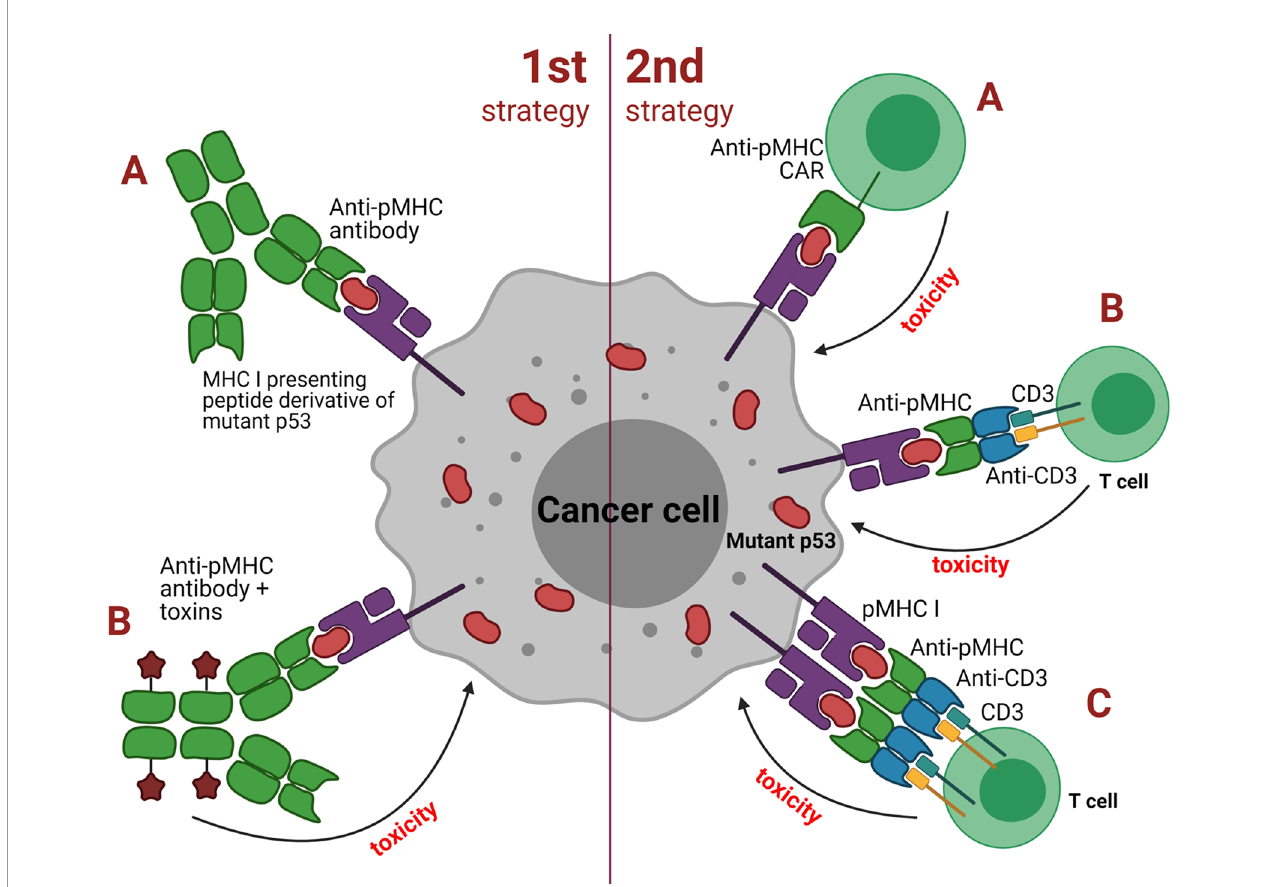
FIGURE 3 | Two strategies employed by TCR mimic antibodies against cancer cells with mutant p53. First strategy: (A) classical soluble antibodies for binding to pMHC to induce direct apoptosis or targeted destruction of the tumor cell; (B) antibody drug conjugates (ADCs) such as effector molecules, cytokines, toxins or radioactive substances that are coupled to the antibody and upon binding to pMHC result in tumor cell death. Second strategy: (A) anti-pMHC CAR to redirect T cells to recognize and lyse tumor cells via the scFv fragment derived from a TCR mimic antibody; (B) bispeci fi c molecules that bridge cytotoxic T or NK cells with pMHC of the antigen-presenting tumor cell using of the scFv fragment of a TCR mimic antibody; (C) similar to B but employs dimeric bispeci fi c T cell-engaging tandem scFv